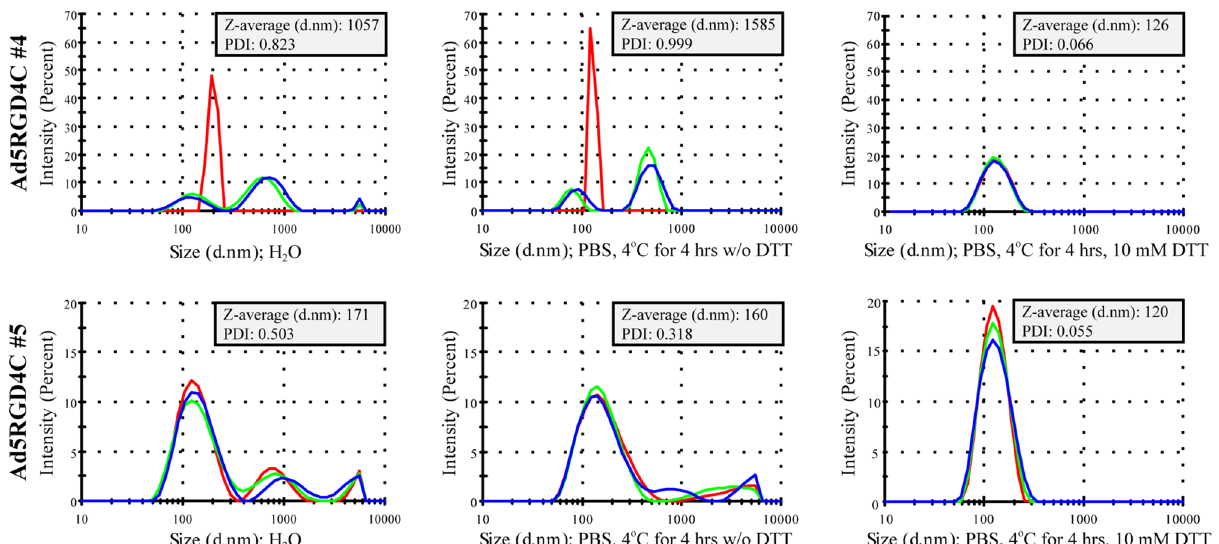
Figure 2. Visible macroscopic and invisible microscopic aggregates of recombinant adenoviruses with the RGD4C peptide inserted in the HI loop of the fiber knob domain could be resolved by the reducing reagent dithiothreitol. Representative macroscopically aggregated rAds (Ad5RGD4C#4 and Ad5RGD4C#5) incubated with the reducing reagent DTT showed size distributions by intensity, the intensity weighted mean hydrodynamic sizes (Z-averages, d.nm) and polydispersity indices (PDI) comparable to the values determined for non-aggregated adenoviral preparations. The measurements were carried out at a rAd concentration of 3 × 10 10 vp in 1 ml total volume in deionized water immediately after viral aliquot sample thawing or in PBS after incubating at 4 °C for 4 h with or without the addition of 10 mM DTT. Each color curve represents an instrumental individual measurement